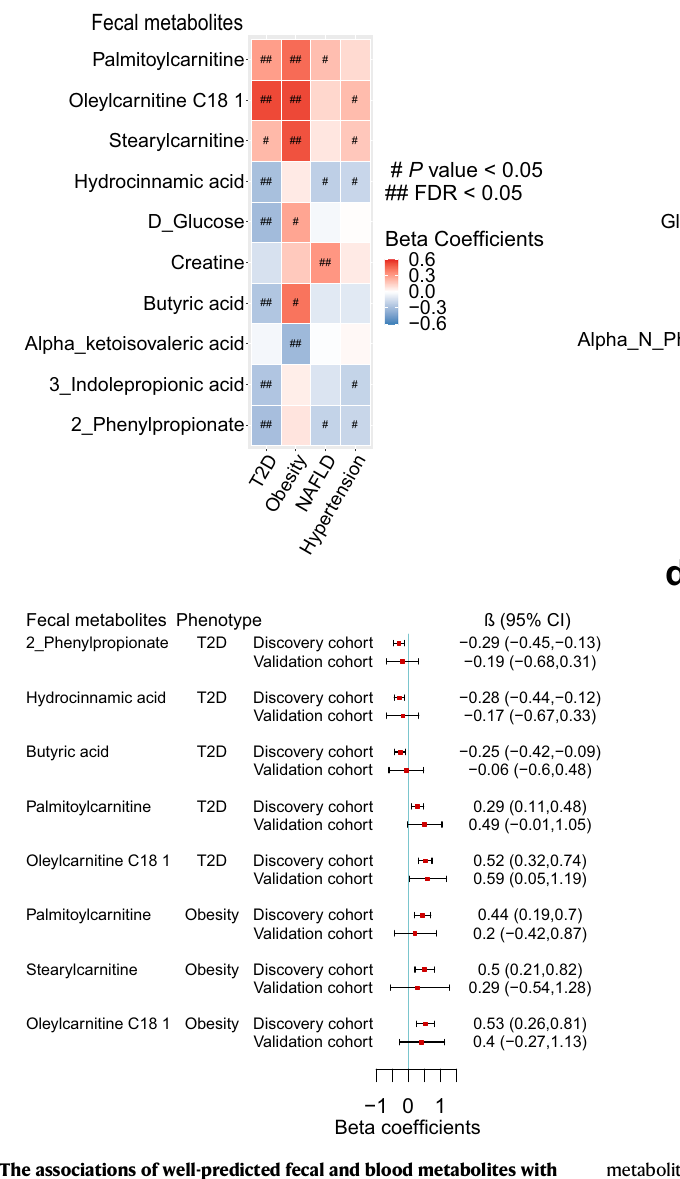
metaboliteswith cardiometabolicdiseases inthe validationcohort( n =1007 in the discoverycohort; n =103inthe validationcohort).Errorbarsarepartialregression coef fi cients with 95% con fi dence intervals. d The scatter plot demonstrates the partial regression coef fi cients for the associations of well-predicted fecal metabo- liteswithcardiometabolicdiseasesobtainedinthediscovery( x axis)andvalidation cohort( y axis).Thecorrelationbetweenthepartialregressioncoef fi cientsobtained in the discovery and validation cohort is computed by Pearson correlation. Error bandislinearregressionlinewith95%con fi denceband.Allstatisticaltestsaretwo- sided. Source data are provided as a Source Data fi le. T2D, type 2 diabetes;